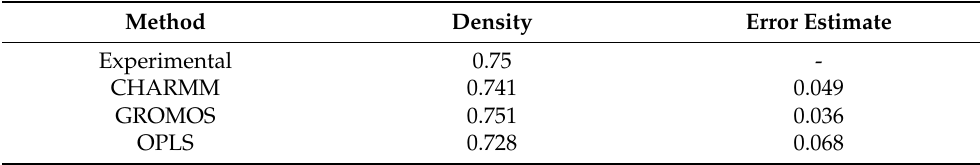
Table 1. Density (in g/cm 3 ) of 1,9-Decadiene from the MD simulations with different force field